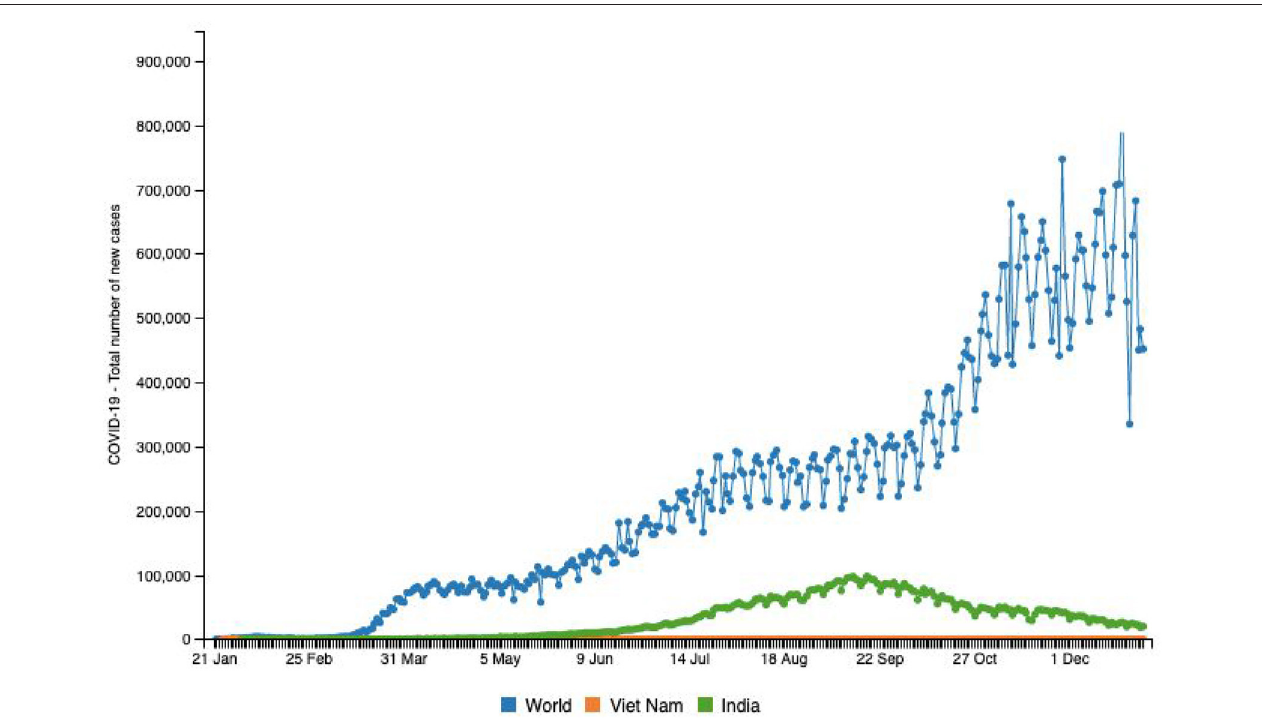
FIGURE 5 | Source: http://www.smaartrapidtracker.org, accessed on December 29, 2020. Total number of new cases of COVID-19 in the world, Vietnam, and India (January 21, 2020 to December 29,